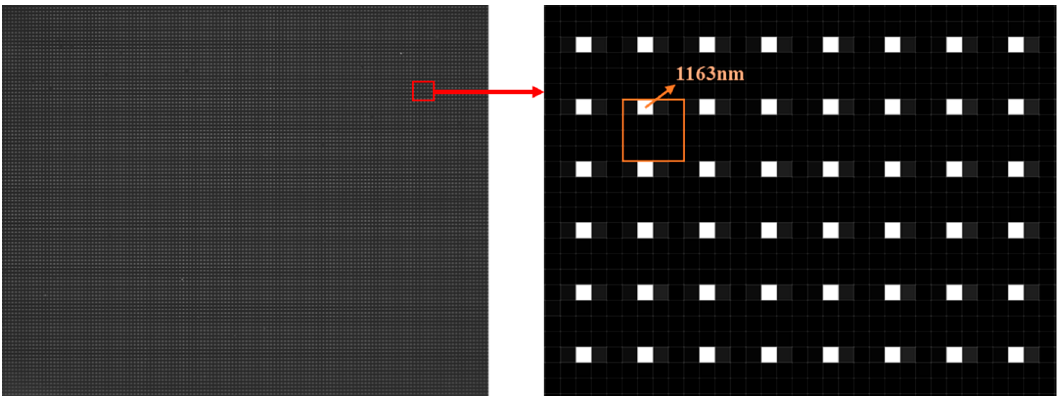
Figure 13. A raw image of monochromatic light with a wavelength of 1163 nm and its enlarged version.